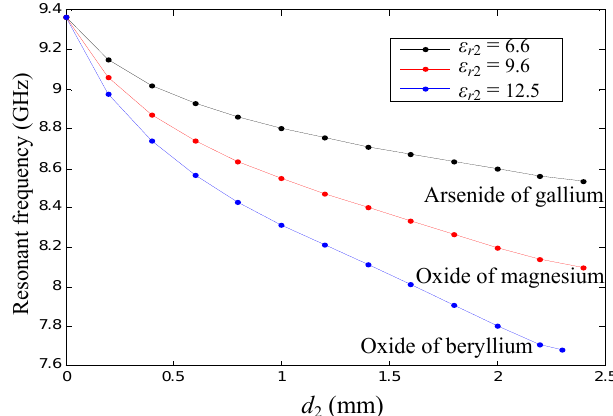
Figure 2: Resonant frequency of the superconducting patch versus the superstrate